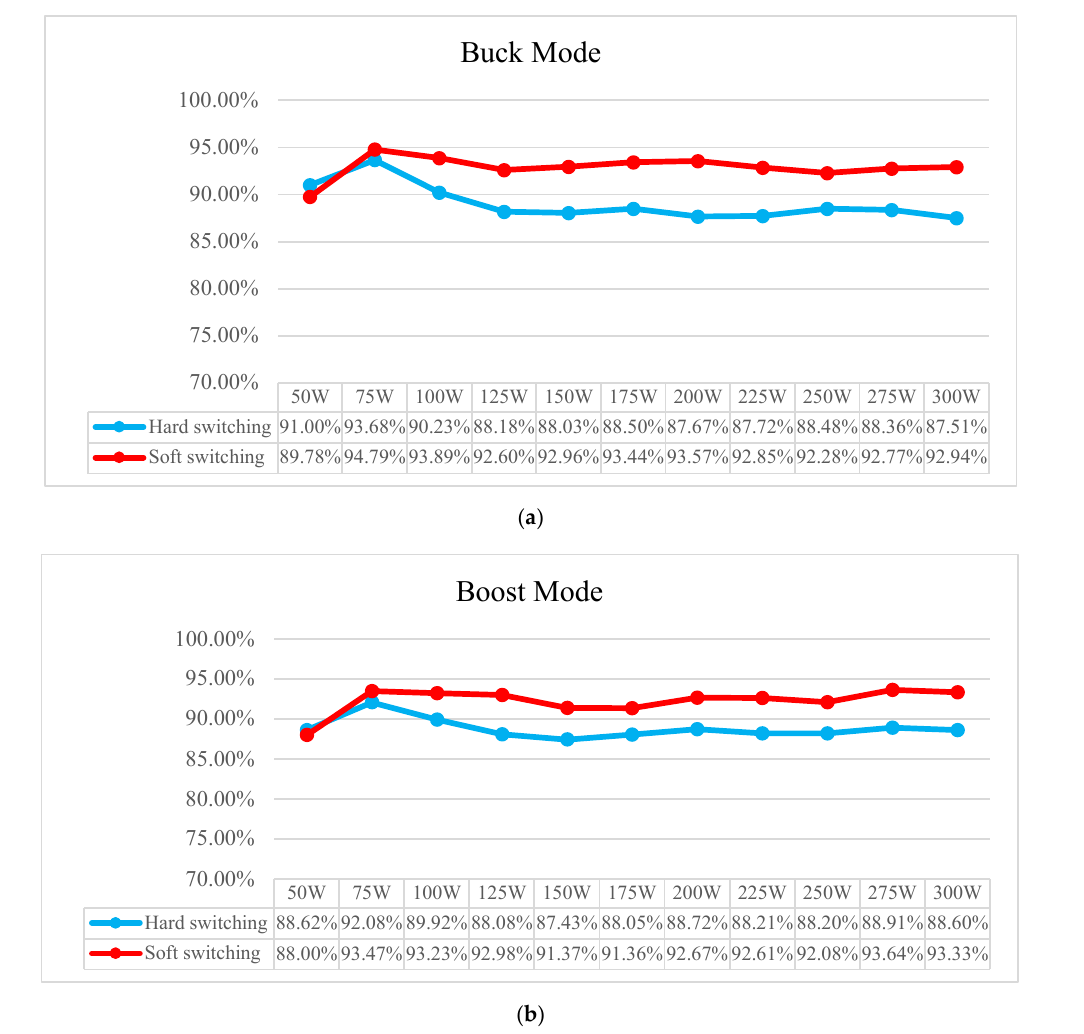
Figure 9. The actual test efficiency comparison between traditional hard-switching and proposed soft-switching converter: ( a ) buck mode; ( b ) boost mode. Table 4. The different output power rates of the photovoltaic module, the initial voltage of each set of batteries, and the final voltage after reaching uniform charging and discharging